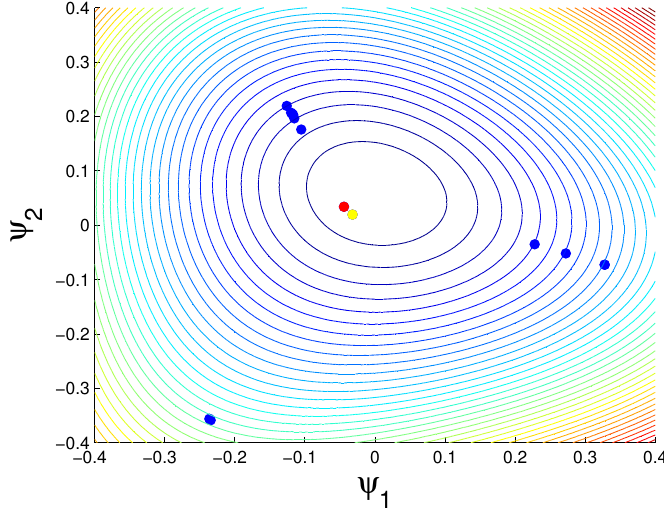
Figure 4. Center of disease